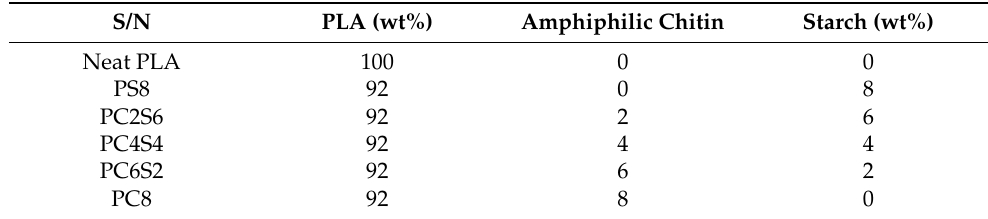
Table 1. Composition variation of the biocomposite. S/N PLA (wt%) Amphiphilic Chitin Starch (wt%) Neat PLA 100 0 0 PS8 92 0 PC2S6 92 PC4S4 PC6S2 PC8 92